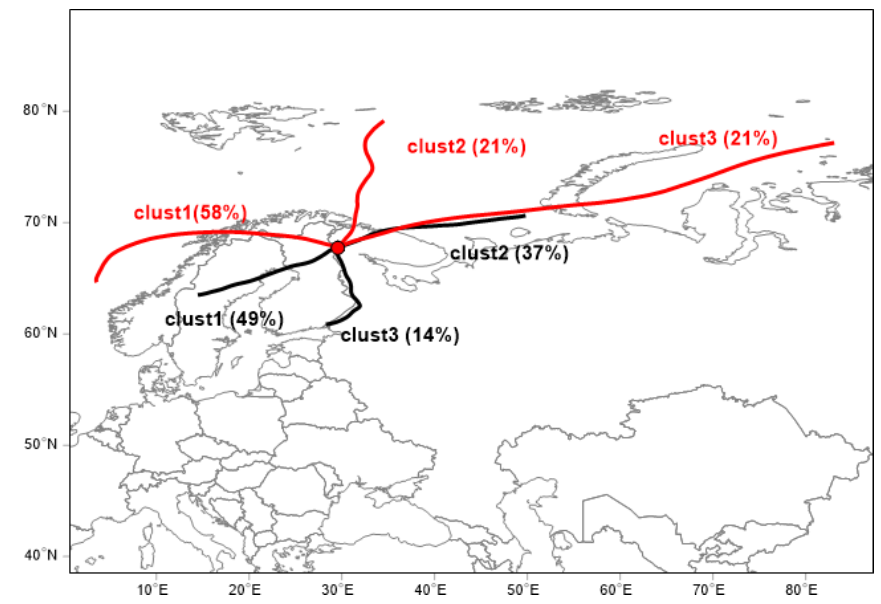
Figure 10. Trajectory cluster analysis of 72h back trajectories simulated at an arrival height of 250ma.g.l.; NCEP/NCAR Reanalysis data were used as the meteorological input. Red denotes an NPF event, and black denotes a non-NPF